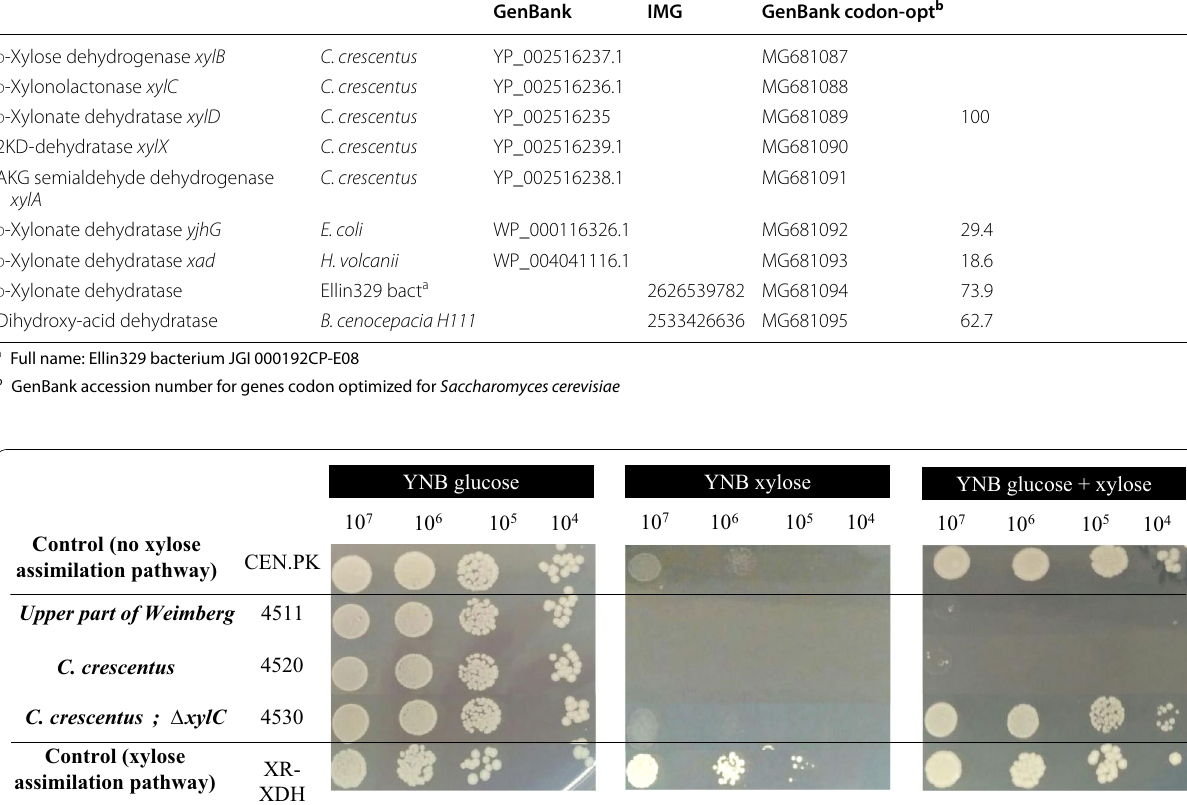
Fig. 2 Evaluation of the growth capacity of yeast strains engineered with Weimberg pathway genes. The dot plating tests were done in defined agar‑medium supplemented with d ‑glucose, d ‑xylose or a mixture of d ‑glucose and d ‑xylose. The background strain CEN.PK 113‑7D was used as negative control for growth on d ‑xylose (first row). As a positive control for growth on d ‑xylose, a strain engineered with an optimized d ‑xylose oxido‑reduction route (TMB4545) was used (last